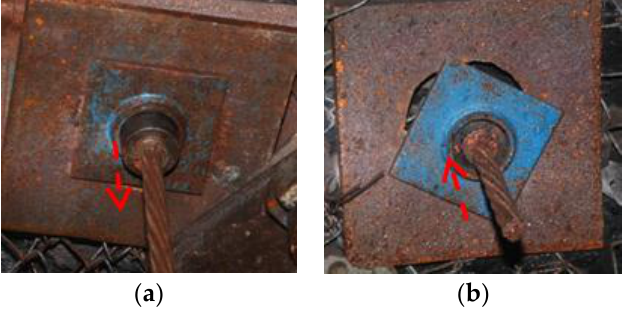
Figure 14 . Constant resistance anchorage lock energy absorption: ( a ) Before anchor lock plastic slip; ( b ) After anchor lock plastic slip.